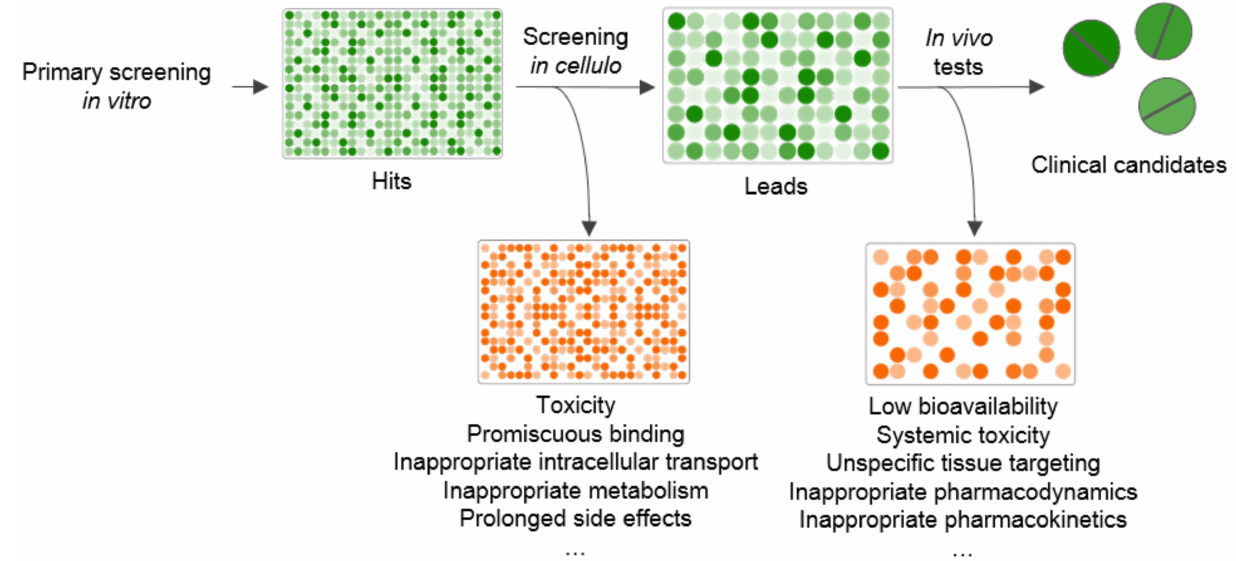
Figure 1. Schematic diagram of drug screening systems. The simpler the initial experimental model is, the more significant proportion of hits is dropped out due to undesired effects in live systems. Green—promising hits, red—dropped out